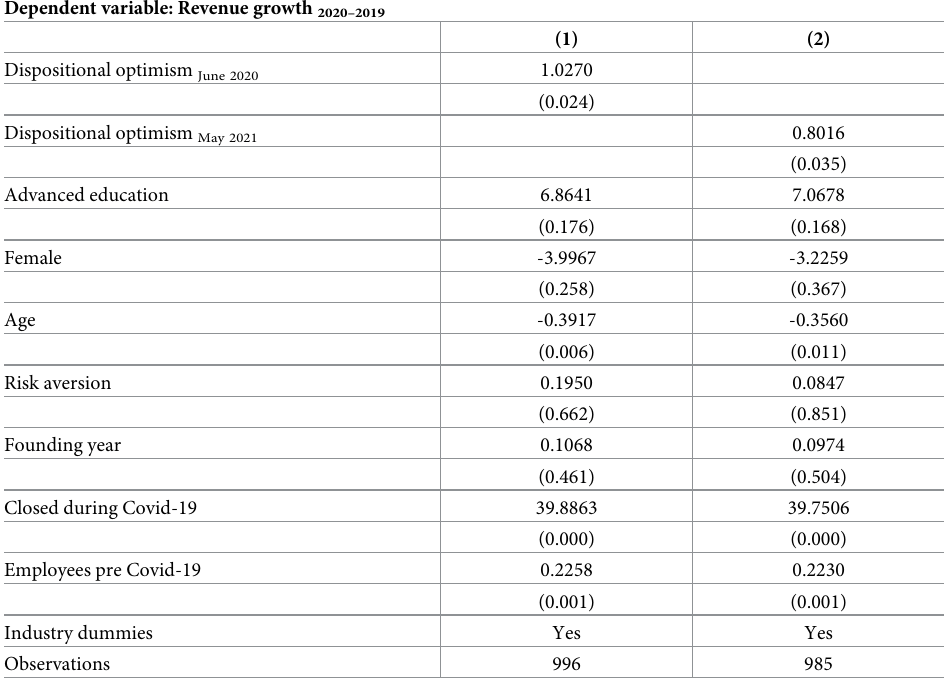
Table 7. Optimism and business